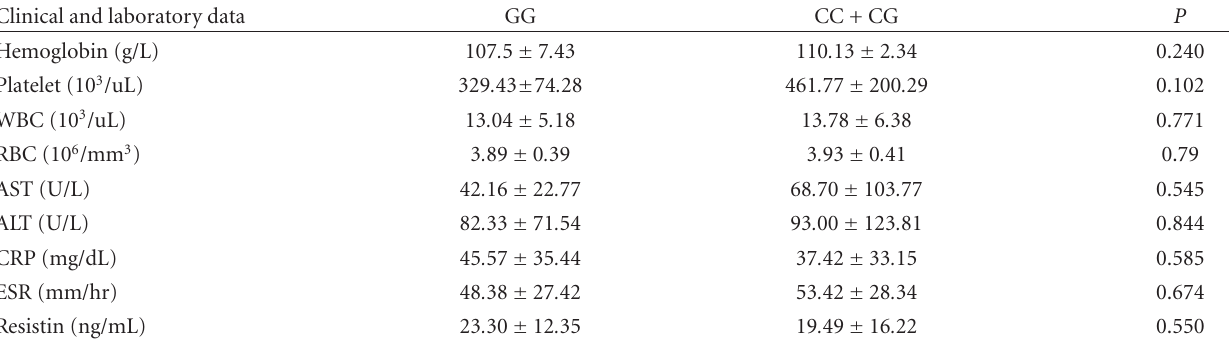
Table 8: Association between RETN ( − 420C > G) alleles and clinical and laboratory data obtained from children with the Kawasaki disease.